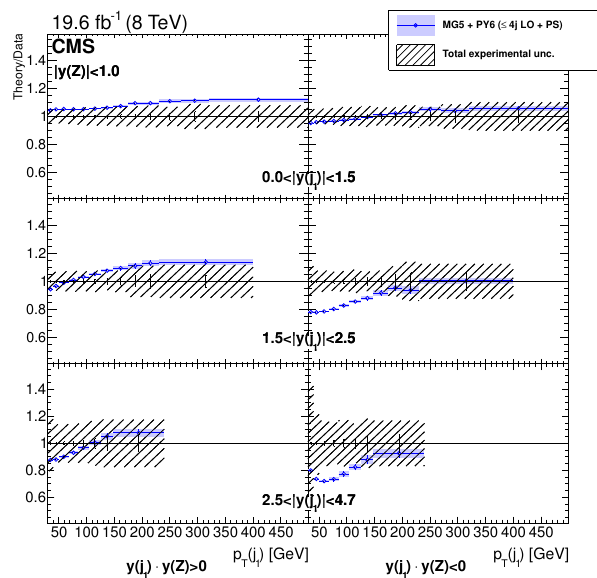
Figure 38 . Ratio to the measurement of the di(cid:11)erential cross section d 3 (cid:27)= d p T (j )d y (j )d y (Z) 1 1 obtained with MadGraph 5 + pythia 6, with up to four jets at LO, for j y (Z) j < 1. Left column corresponds to y (j ) y (Z) > 0 and right column to y (j ) y (Z) < 0. The total experimental uncertainty 1 1 is shown as a band around 1. Uncertainties in the predictions are shown on the ratio points and include the statistical uncertainty only.